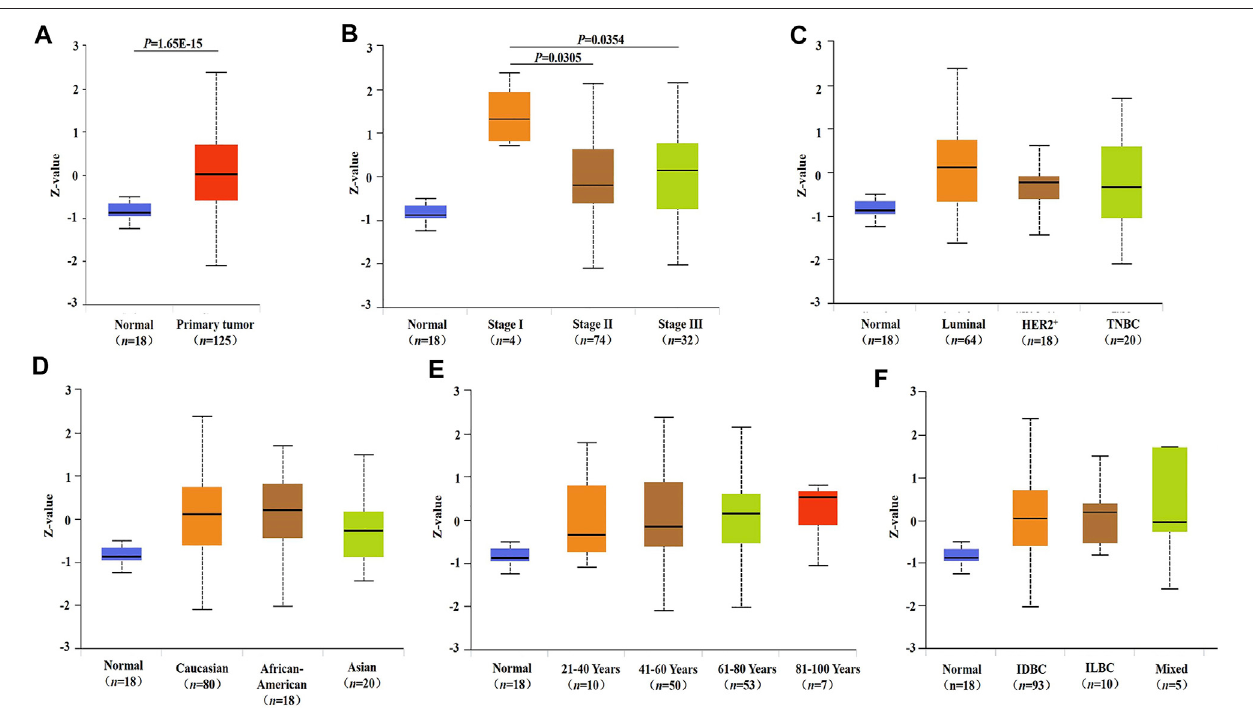
FIGURE 2 | INHBA protein expression and its relationship with clinicopathological factors in breast cancer. (A) Protein expression of INHBA in primary breast cancerandnormaltissuesanalyzedbyUALCAN. (B – F) RelationshipbetweenproteinexpressionofINHBAandclinicopathologicalfeaturesinbreastcanceranalyzedby UALCAN. Z-values represent standard deviations from median across samples for given cancer type. Log2 Spectral count ratio values from Clinical Proteomic Tumor Analysis Consortium were fi rst normalized within each sample pro fi le, then normalized across samples. IDBC, Invasive ductal breast carcinoma; ILDC, Invasive lobar breast carcinoma; Mixed, Mixed lobular and ductal breast